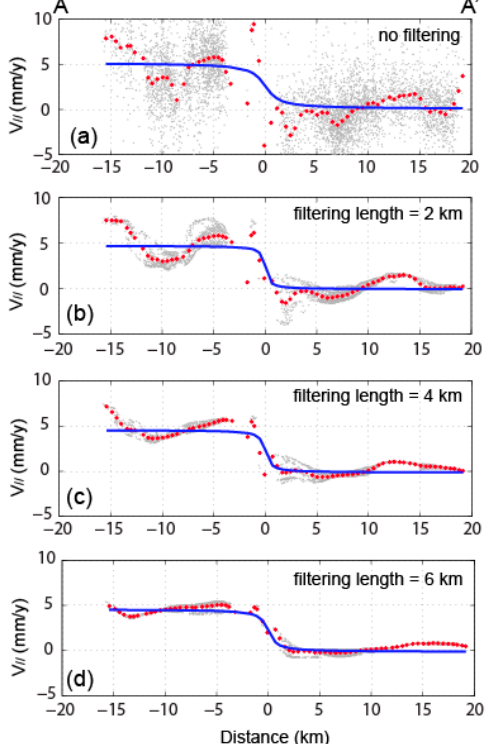
Figure 7. Decomposed horizontal velocity (N30°W) on profiles perpendicular to the orientation of the fault and comparisons to the model predictions that were inferred from the optimal fault parameters: ( a ) Original fault-parallel velocity without spatial filtering; ( b – d ) Velocity profiles obtained from low-pass filtered data. The blue lines in each subfigure are the forward predictions based on the inverted optimal fault parameters. In each subfigure, the gray dots show the original or filtered data along the profile, and the red dots represent the mean values at each distance along the profile. The location of this profile is shown in Figure 6.